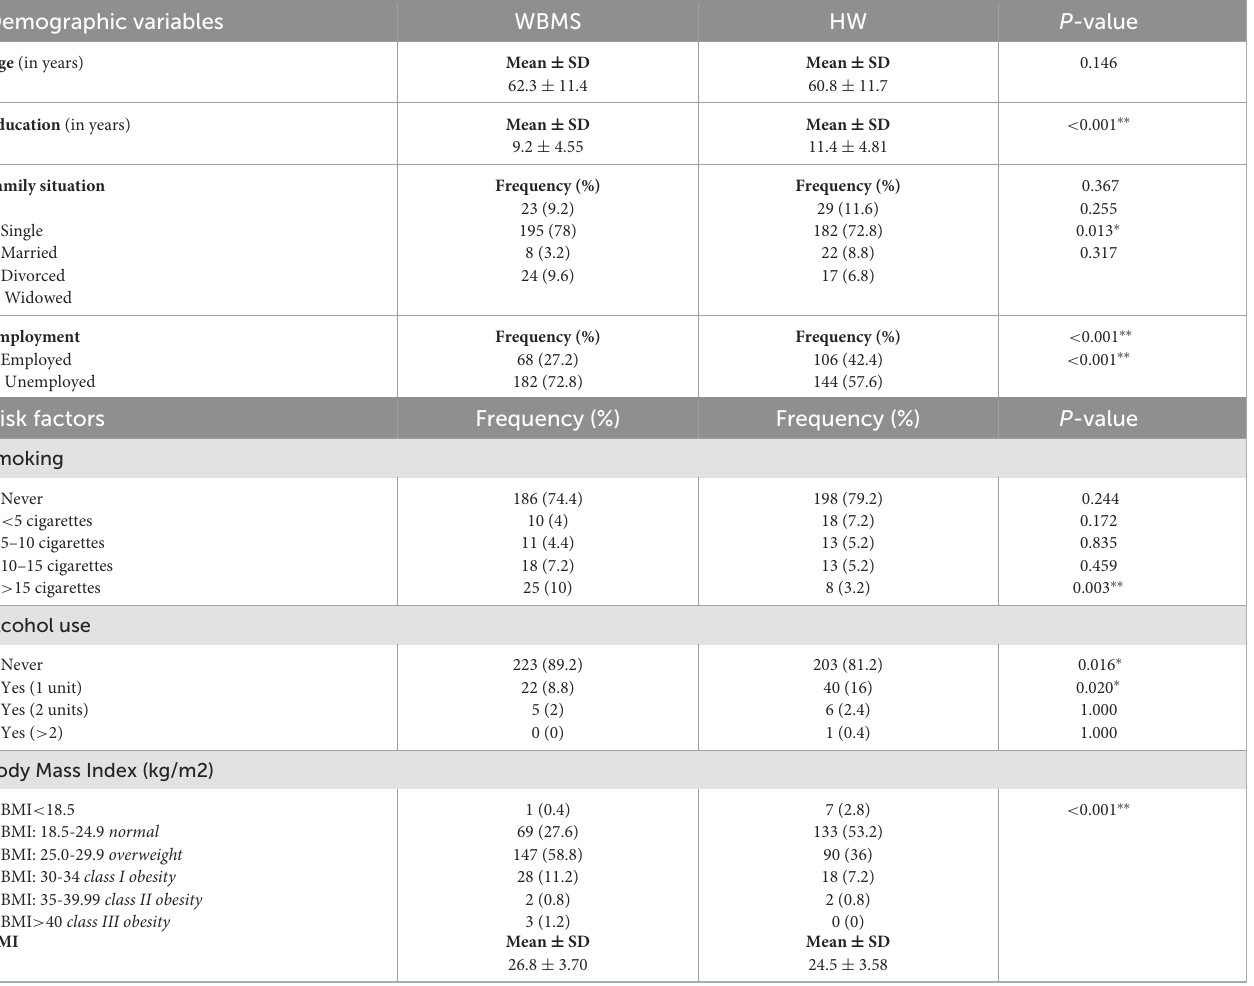
TABLE 1 Socio-demographic profile and risk factors of 250 WBMS patients and 250